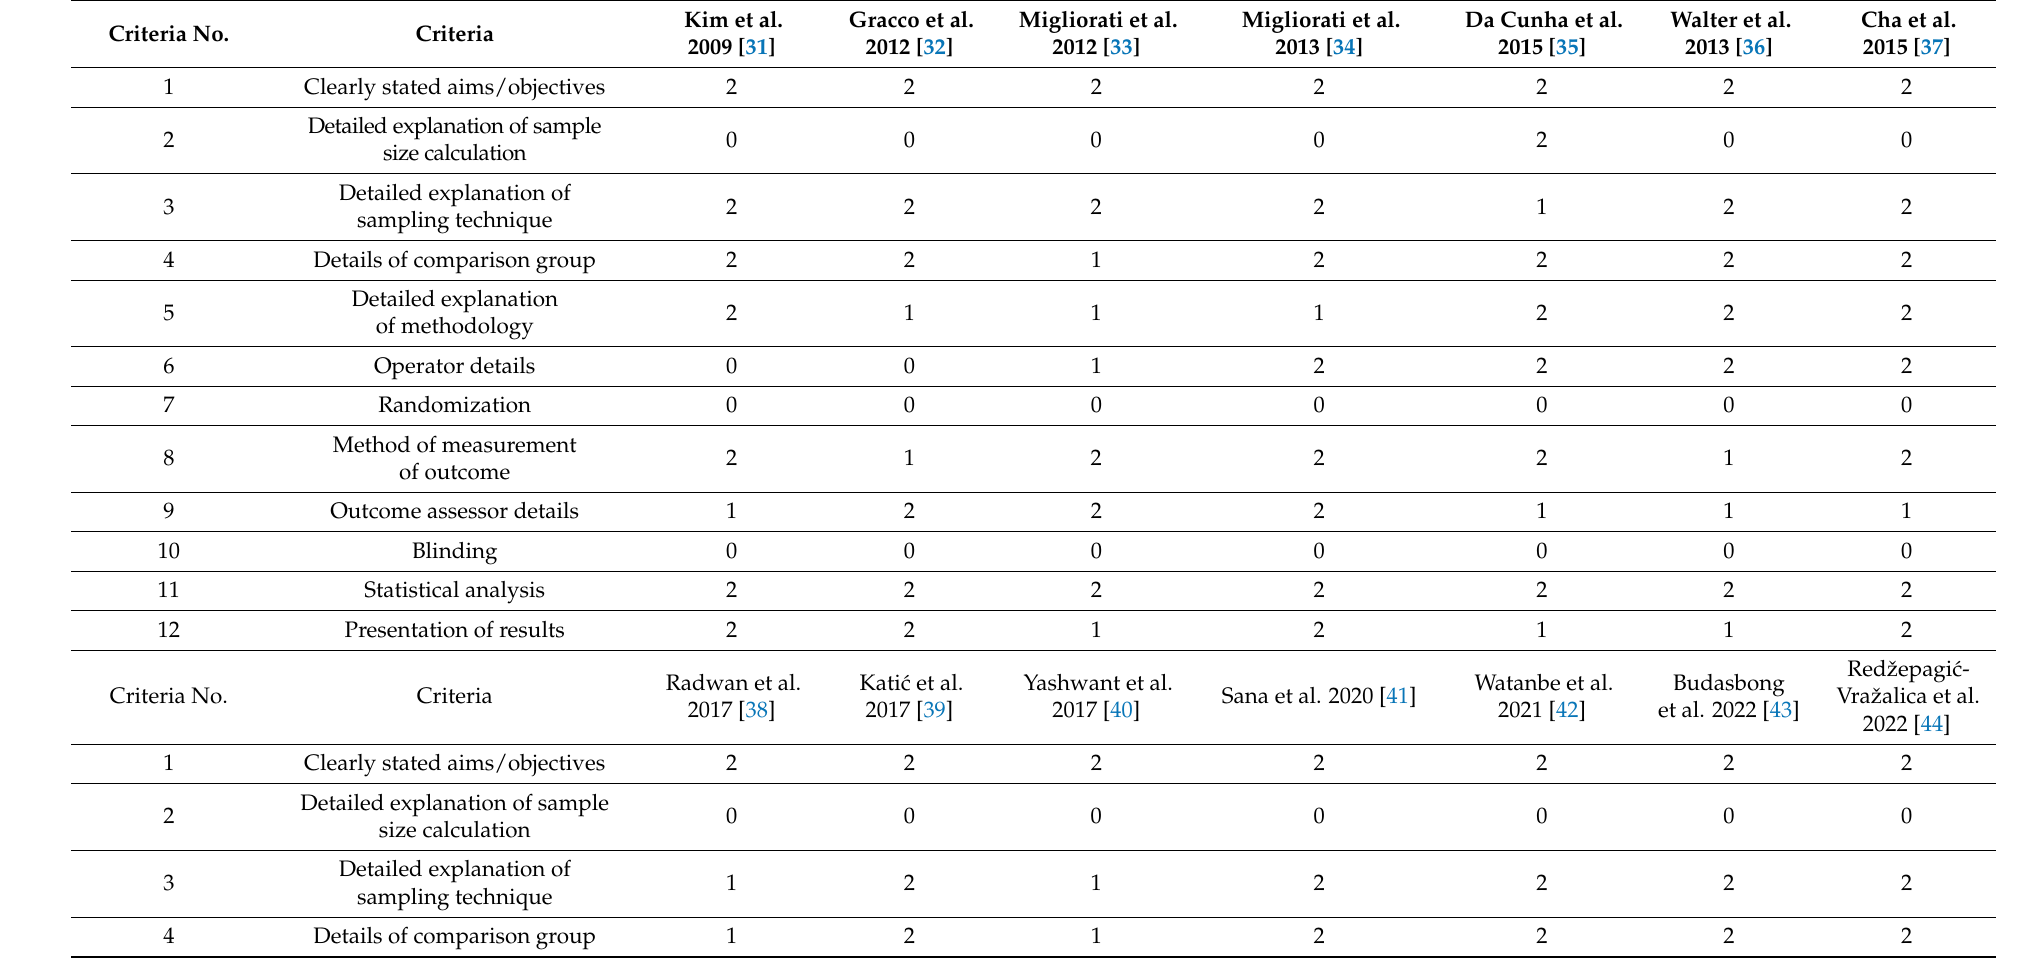
Table 4. Quality assesment of in-vitro studies according to QUIN assesment